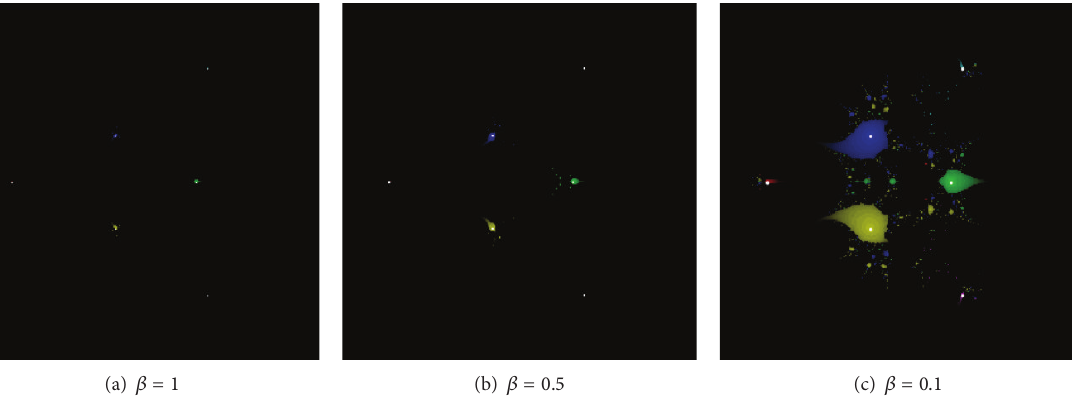
Figure 3: Scheme (3) for the test problem 2.